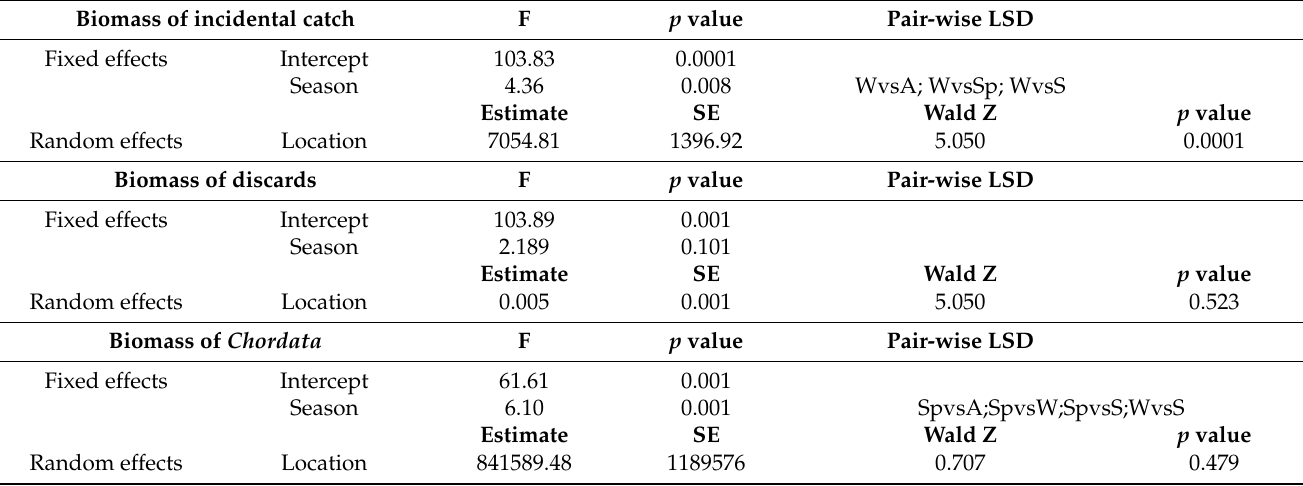
Table A3. Linear Mixed Model Effects results regarding species biomass with season (fixed factor) and location (random factor) as